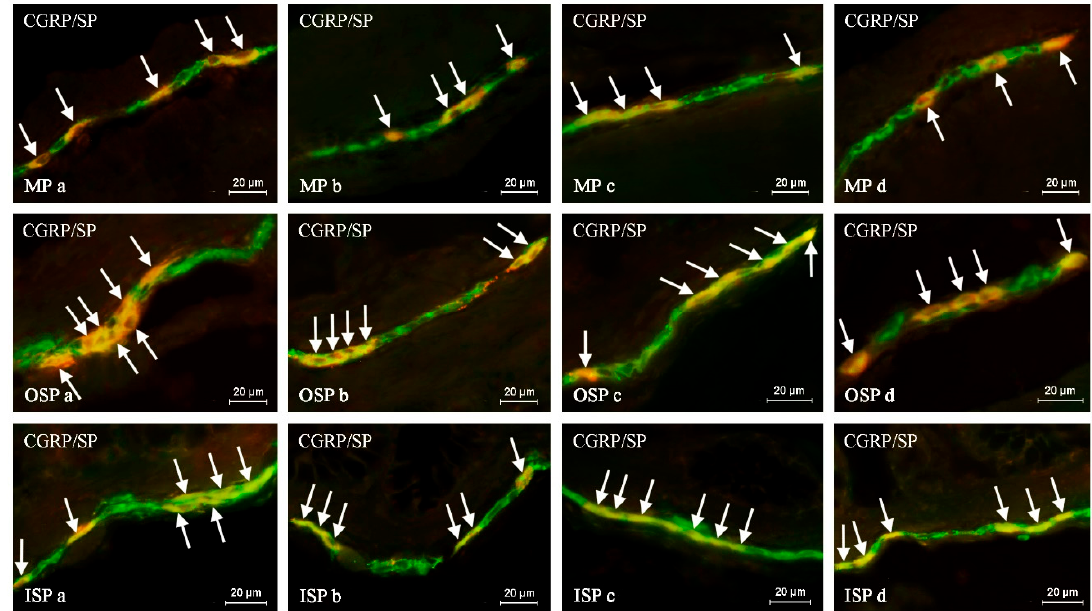
Figure 2. The representative images of the co-localization of calcitonin gene-related peptide (CGRP) with substance P (SP) in the neurons of the myenteric plexus (MP), outer submucous plexus (OSP) and inner submucous plexus (ISP) of the porcine descending colon under physiological conditions in young females ( a ), young males ( b ), adult females ( c ) and adults males ( d ). The images are composites of merged photographs taken separately from green (CGRP) and red (SP) fluorescent channels. Nervous structures, where CGRP co-localizes with SP, are indicated by arrows. Table 2. The co-localization of CGRP with substance P (SP) in the enteric nervous structures of the porcine descending colon under physiological conditions in young (10-week old) females and males and adult (6–8 months old) females and males.